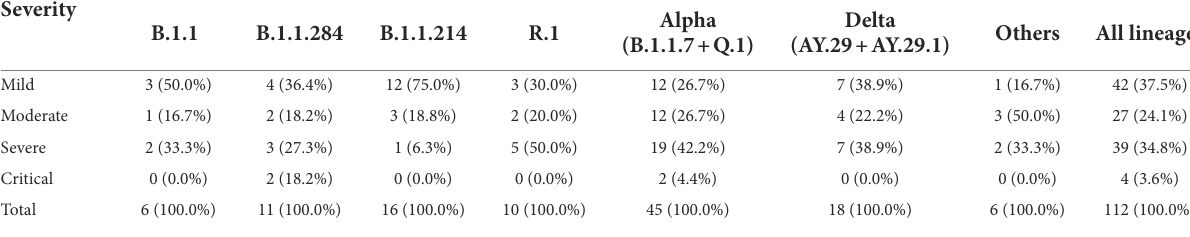
TABLE 3 Severity of the patients infected with the representative lineages at Juntendo University